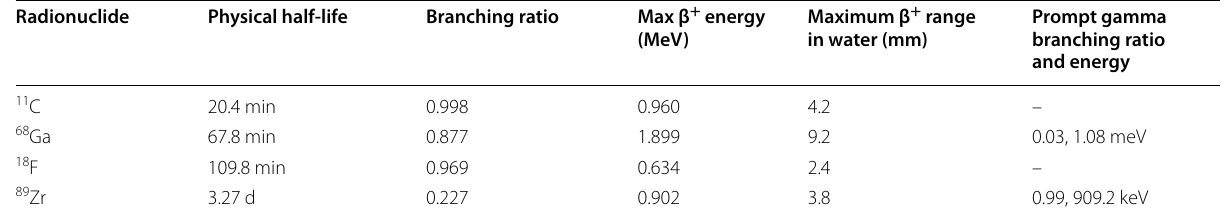
Table 2 Physical properties of different radionuclides used for PET image quality evaluation [8] Radionuclide